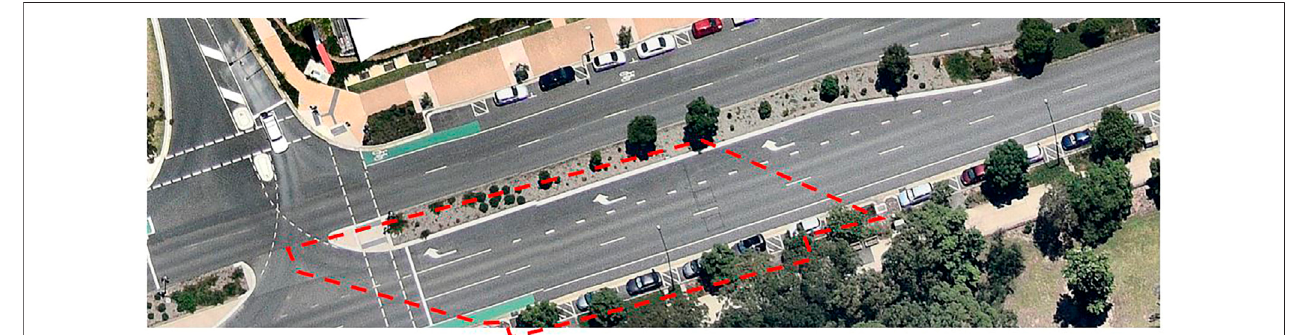
FIGURE 1 | Road catchment from Southeast Queensland (Source: Lucke et al.,